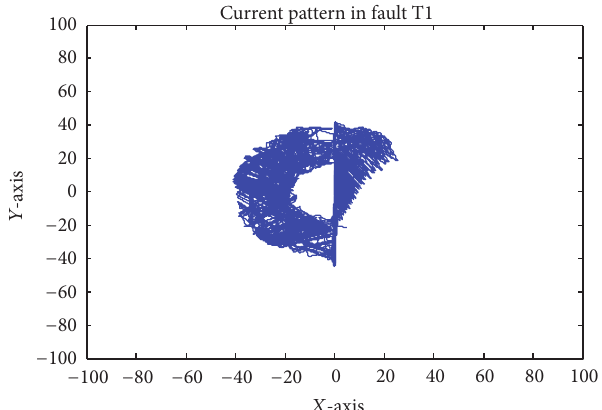
Current pattern in fault T1